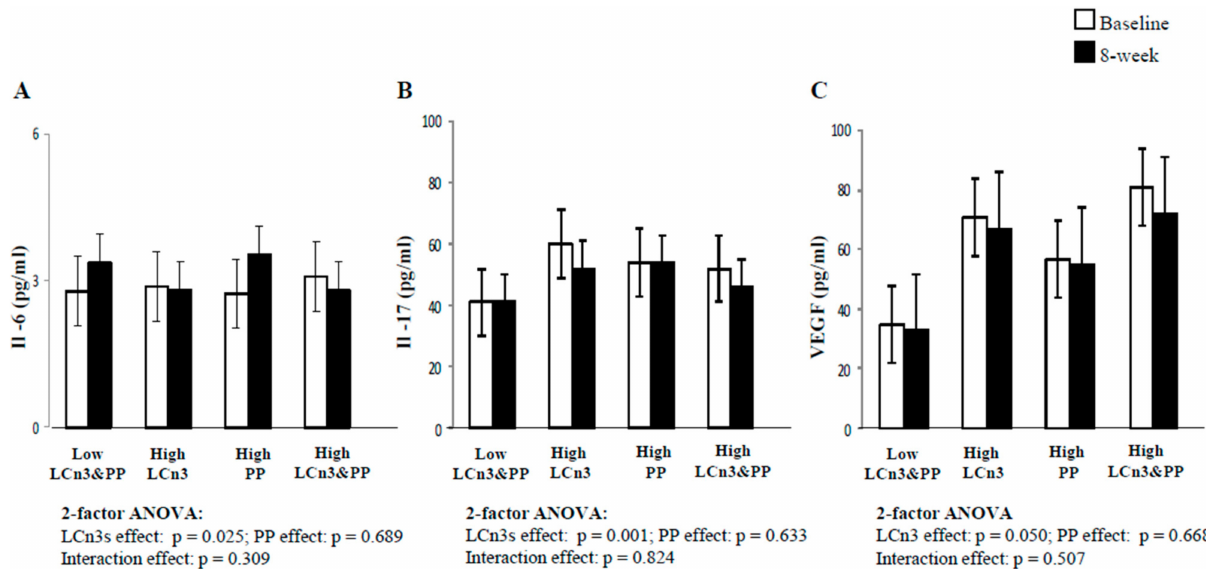
Figure 2. Fasting serum concentrations of IL-6 ( A ), IL-17 ( B ) and VEGF ( C ) at baseline (white square) and 8-week dietary intervention (black square) in the 4 experimental groups. Mean ± SEM. Comparisons made by 2 factor after ANOVA of percent changes in plasma hs-CRP adjusted for sex, age, and baseline BMI.LCn3, long-chain n-3 fatty acids; PP, polyphenols. For IL-6 (A): n = 12 for Control, n = 13 for High LCn3, n = 11 for High PP, n = 13 for High LCn3&PP group. Fasting serum concentrations of VEGF (Figure 2C) decreased after the two High LCn3